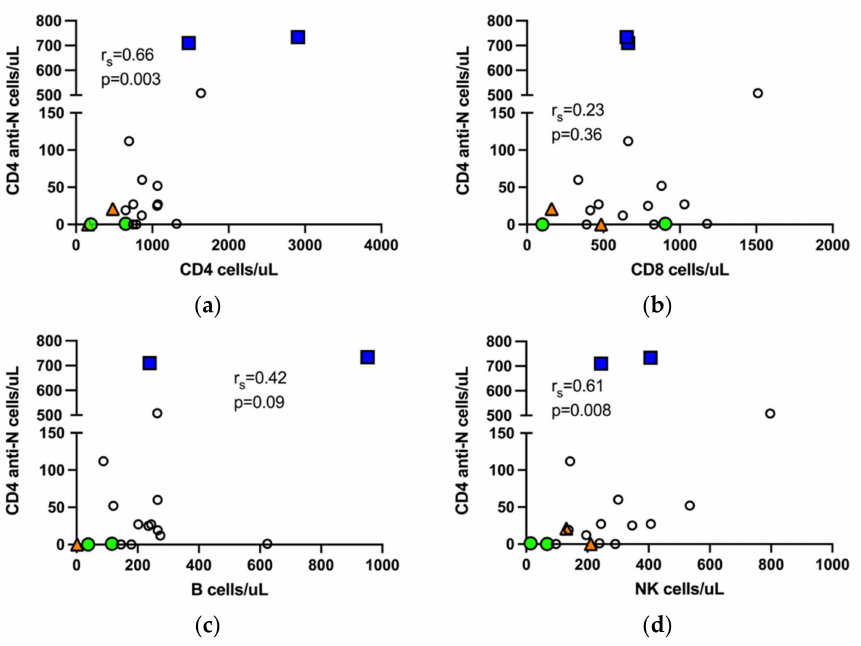
Figure 2. Nucleocapsid specific T cells in the entire study cohort correlate with CD4 T cells and NK cells. Correlation of N-specific CD4 T cells with total number of CD4 T cells ( a ), CD8 T cells ( b ), B cells, sample from a patient with chronic lymphocytic leukemia and B cell count >10,000 is not shown, ( c ) and NK cells ( d ), respectively, in peripheral blood. r s , Spearman